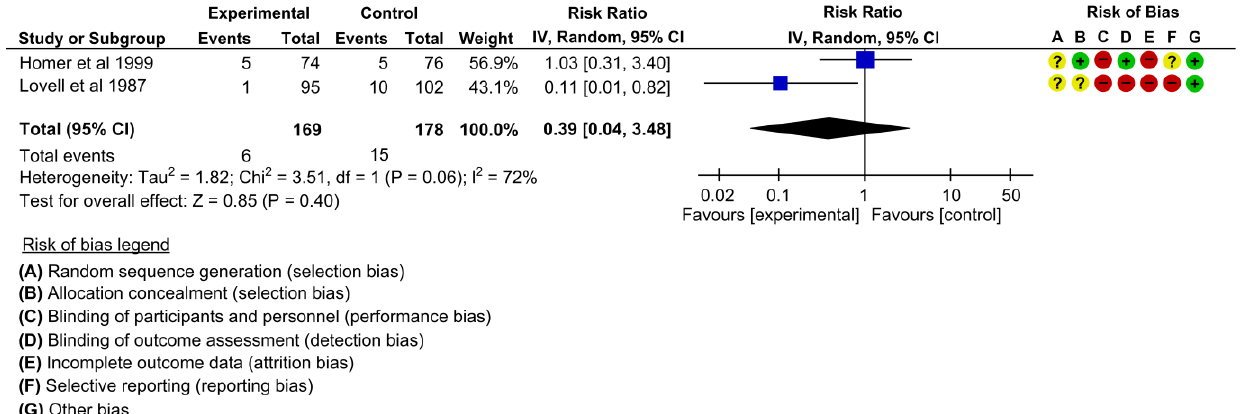
Figure 11. Meta-analysis for the effect of MCH handbook interventions vs. standard care on case notes lost or left at home [22,24]. Red color with a − symbol means a high risk of bias, yellow color with a ? symbol means an unclear risk of bias, and green color with a + symbol means a low risk of